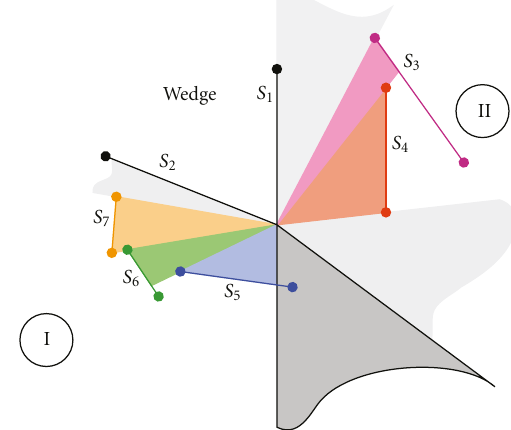
Figure 11: An example of di ff ractive wedge and beams departing from it. Notice that if either the source or the receiver fall outside the regions marked as I and II, then there is direct visibility, therefore di ff raction can be